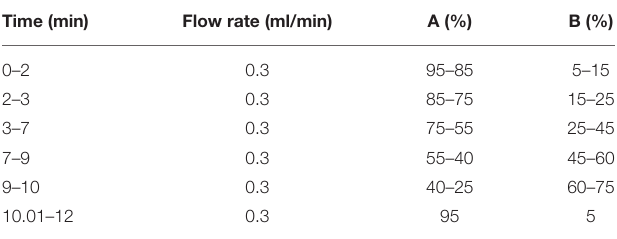
TABLE 1 | The elution gradient of UPLC-Q-Exactive Orbitrap-MS/MS. Time